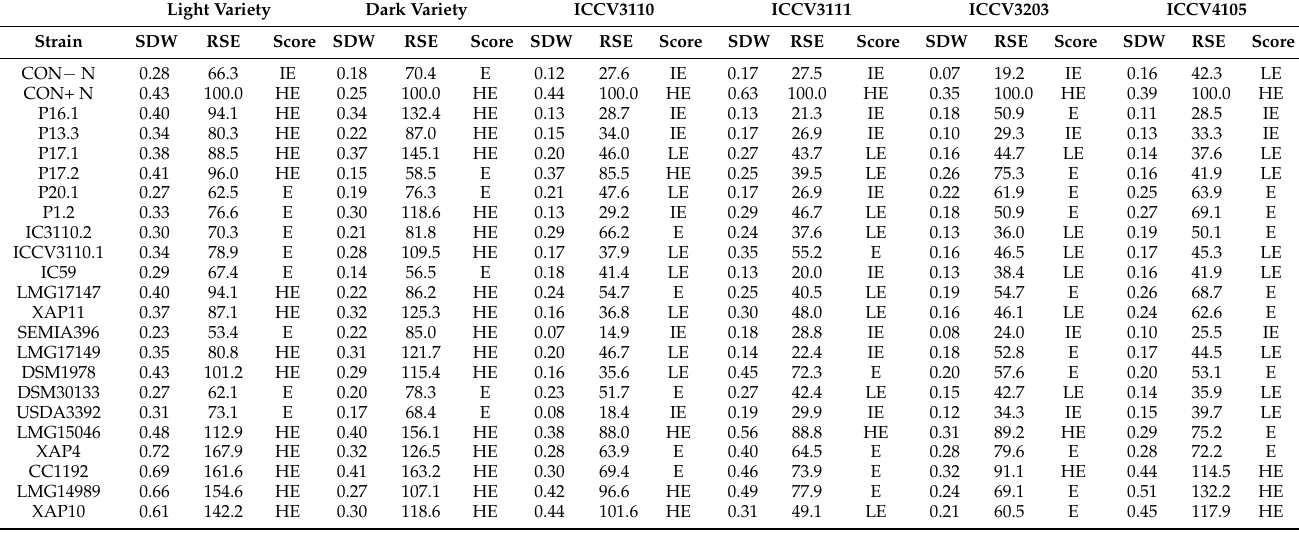
Table 3. Relative symbiotic effectiveness (RSE) scores of the Mesorhizobium strains on the six desi chickpea genotypes